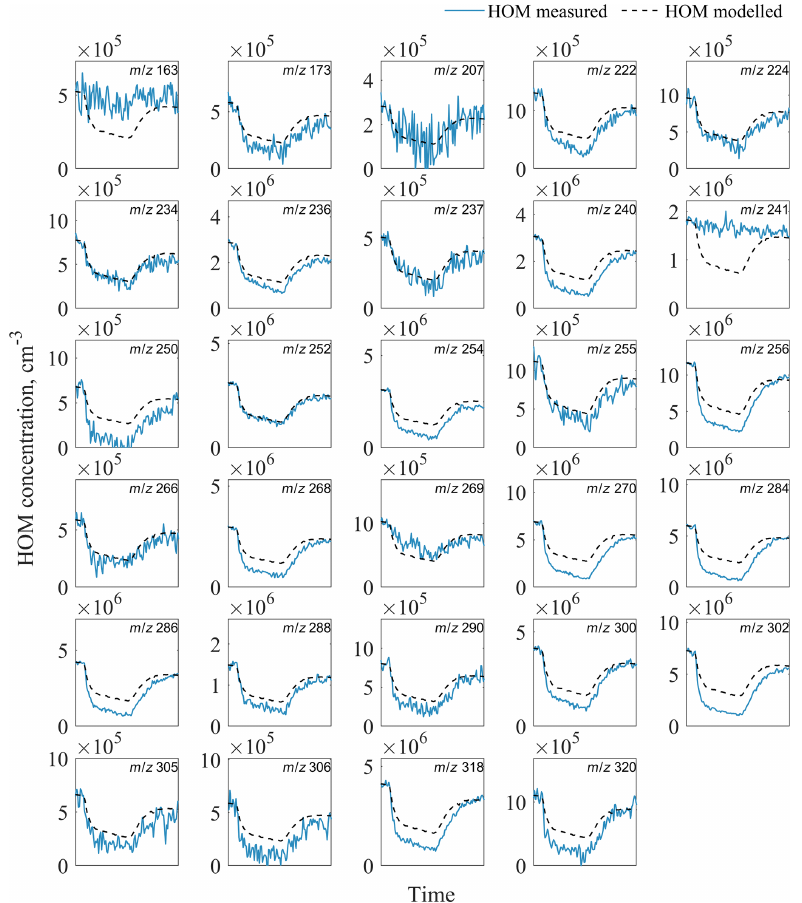
Figure A1. Evolution of measured and modelled HOM monomers during the seed addition experiment. The list of HOM compositions for each peak at corresponding m/z is presented in Table S4 in the